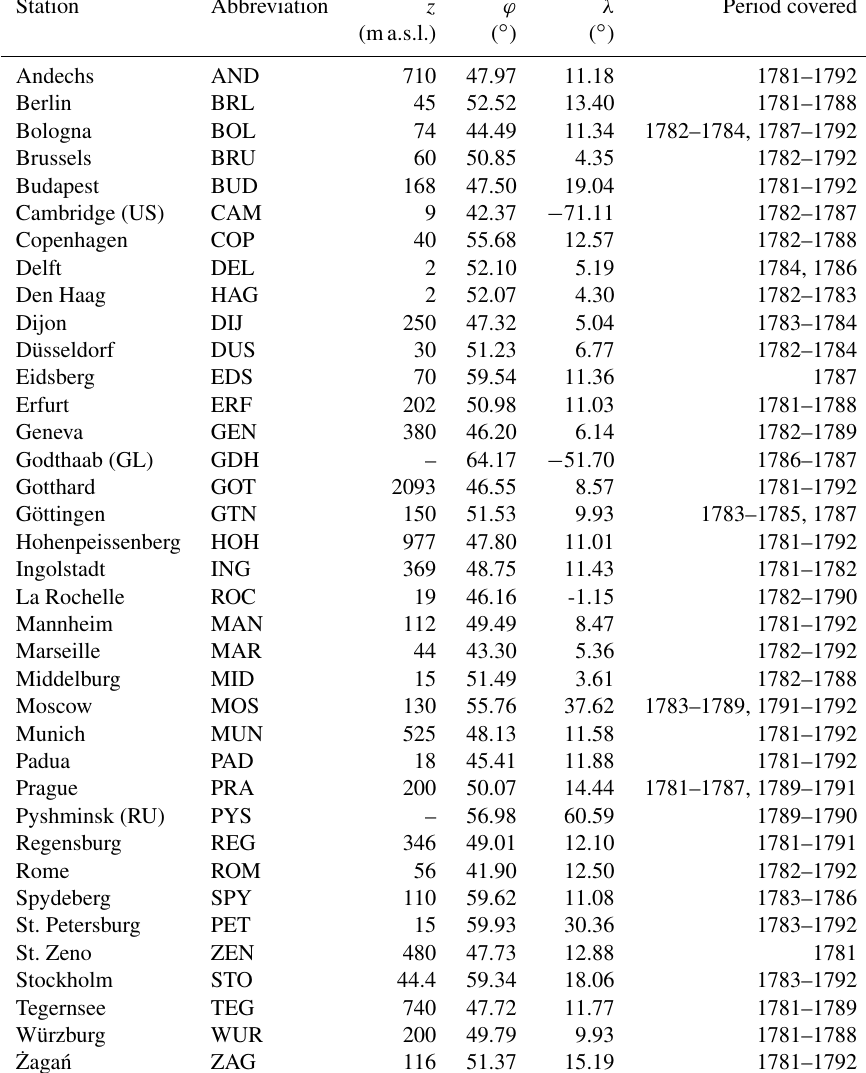
Table 1. List of stations that belonged to the SMP network, including information about height above sea level (estimations based on available information), latitude ( ϕ ), longitude ( λ ), and period for which data are available in the Ephemerides. This is loosely based on a list by Cassidy (1985, pp. 23–24), which does not specify the resolution of the